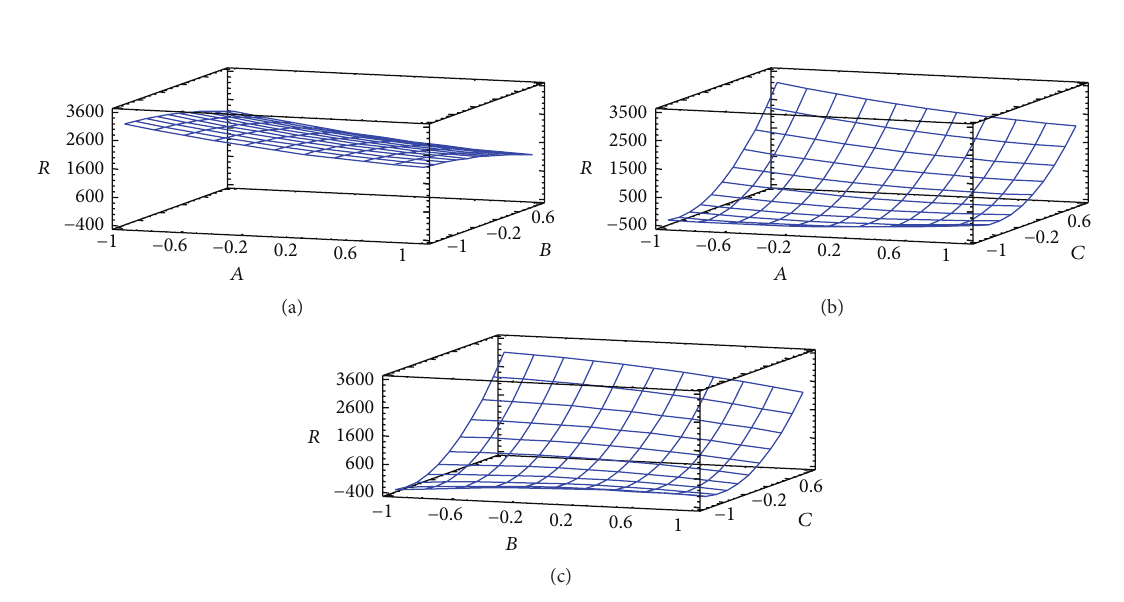
Figure 2: Response surface plots for BBD: (a) pH ( 𝐴 ) versus flow rate ( 𝐵 ) (mobile phase ratio: 95%); (b) pH ( 𝐴 ) versus mobile phase ratio ( 𝐶 ) (flow rate: 1.0 mL/min); (c) flow rate ( 𝐵 ) versus mobile phase ratio ( 𝐶 ) (pH: 6.0).